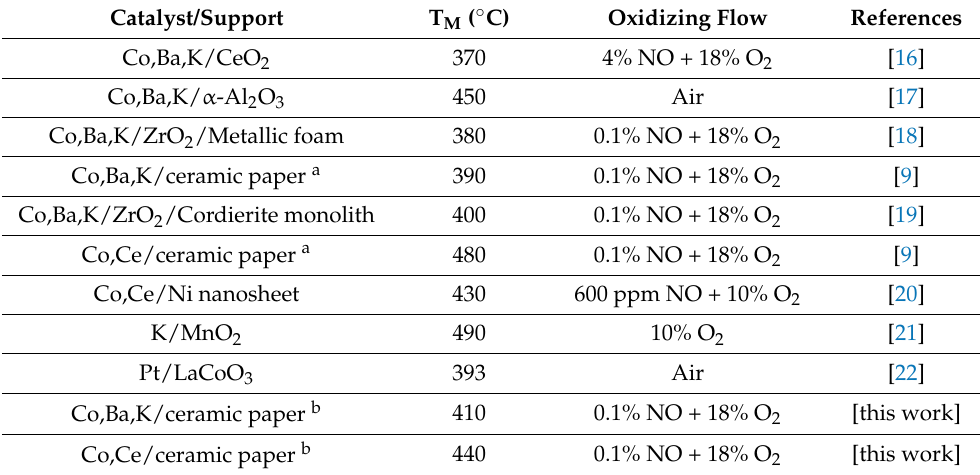
Table 5. Catalytic activity compared with selected catalysts reported for soot